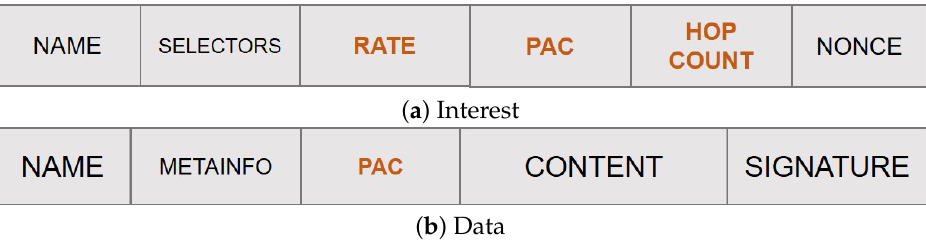
Figure 3. Overhauled NDN packets (fields with text in orange are those added by the PaC- based